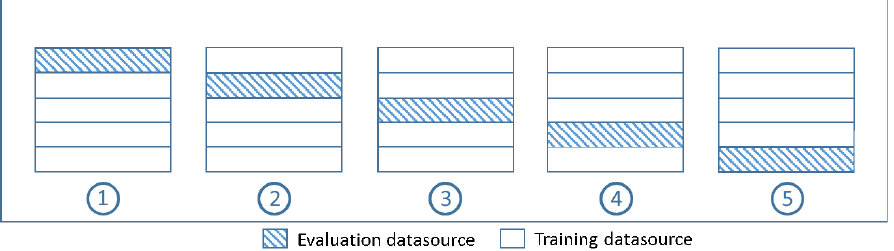
Figure 6. Fivefold cross-validation method: 1—the first section is reserved for validation and rest sections are for train, 2—the second section is reserved for validation and rest sections are for train, 3—the third section is reserved for validation and rest sections are for train, 4—the forth section is reserved for validation and rest sections are for train, 5—the fifth section is reserved for validation and rest sections are for train.